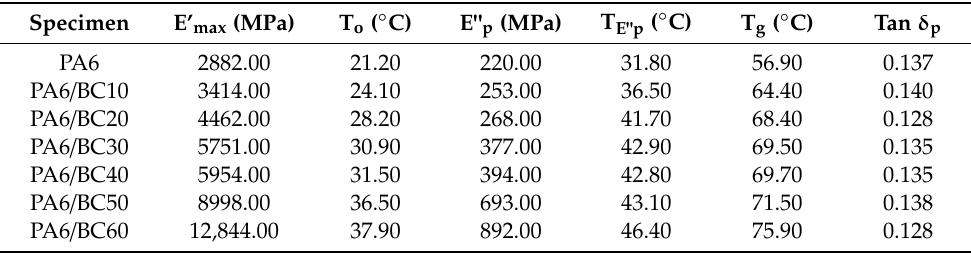
Figure 7. Dynamic thermomechanical analysis (DMA) curves of PA6/BC composites with different BC contents, ( a ) E', ( b ) tan δ . Table 2. Characteristic data for dynamic thermomechanical analysis of PA6 / BC composites with di ff erent BC